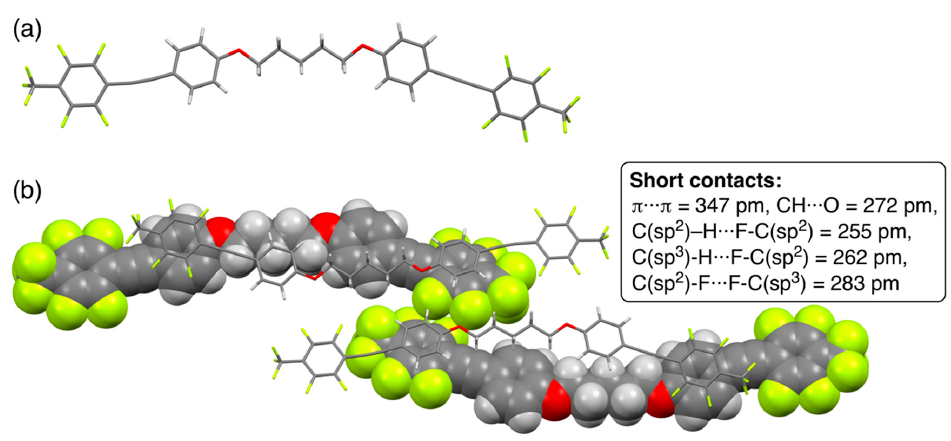
Figure 3. ( a ) Crystal structure of 2a and ( b ) packing structures in a unit cell. Short contacts, which indicate interatomic distances below the sum of van der Waals radii, are also shown. van der Waals radius for carbon (C): 170 pm, hydrogen (H): 120 pm, oxygen (O): 152 pm, and fluorine (F): 147 pm [44].